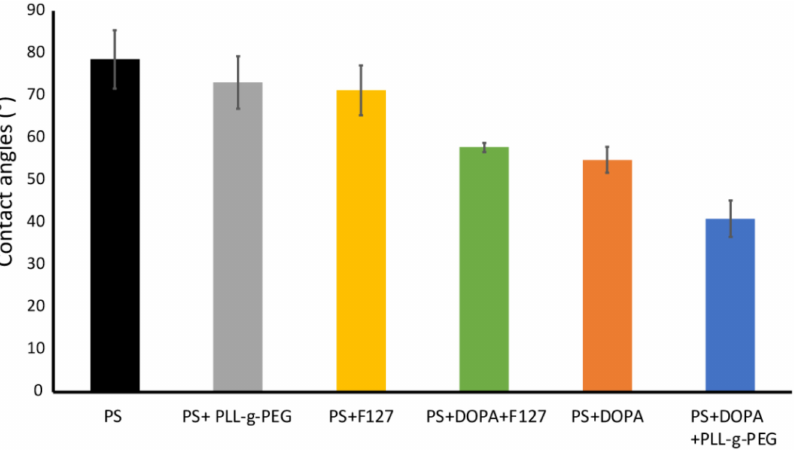
Figure 3. Average contact angles, with standard deviations (error bars), for all surface coatings